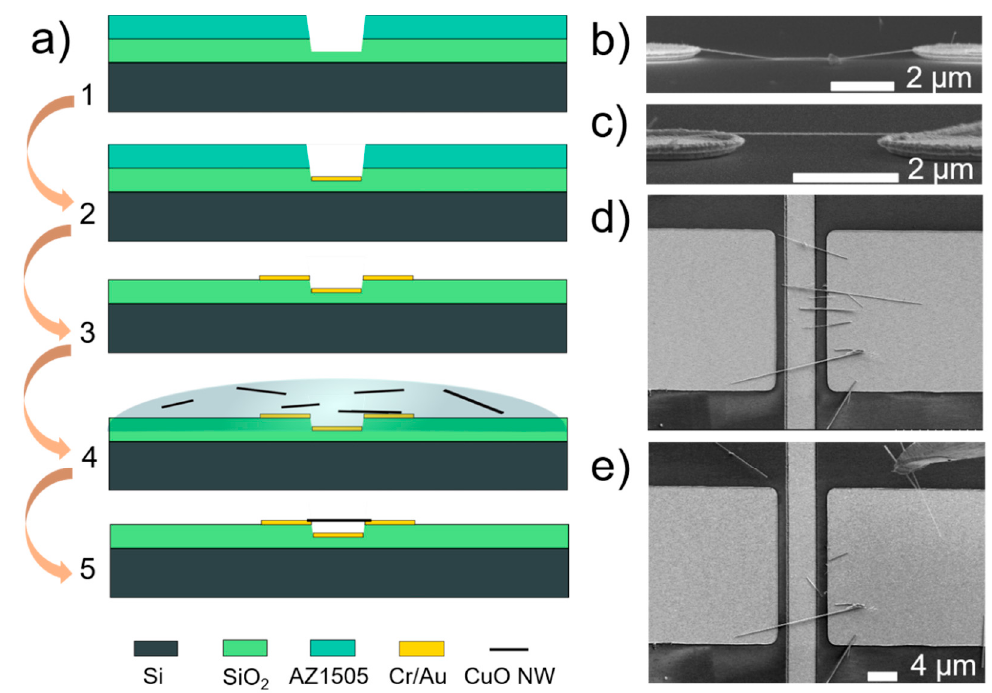
Figure 1. ( a ) Process flow for fabrication of microelectrodes involving etching of thermal SiO 2 (1), deposition of metal electrodes (2, 3) and dielectrophoretic assembly and supercritical drying (4) to yield the final suspended device (5). SEM images showing side view of a single nanowire aligned on 2 μ m wide electrodes by ( b ) DEP without supercritical drying, ( c ) dielectrophoresis (DEP) followed by supercritical drying; ( d ) SEM image showing top-view of multiple nanowires aligned on 20 μ m wide electrodes; and, ( e ) the removal of excess nanowires by nanomanipulations with etched gold tip (tip shown in upper right side of the image).